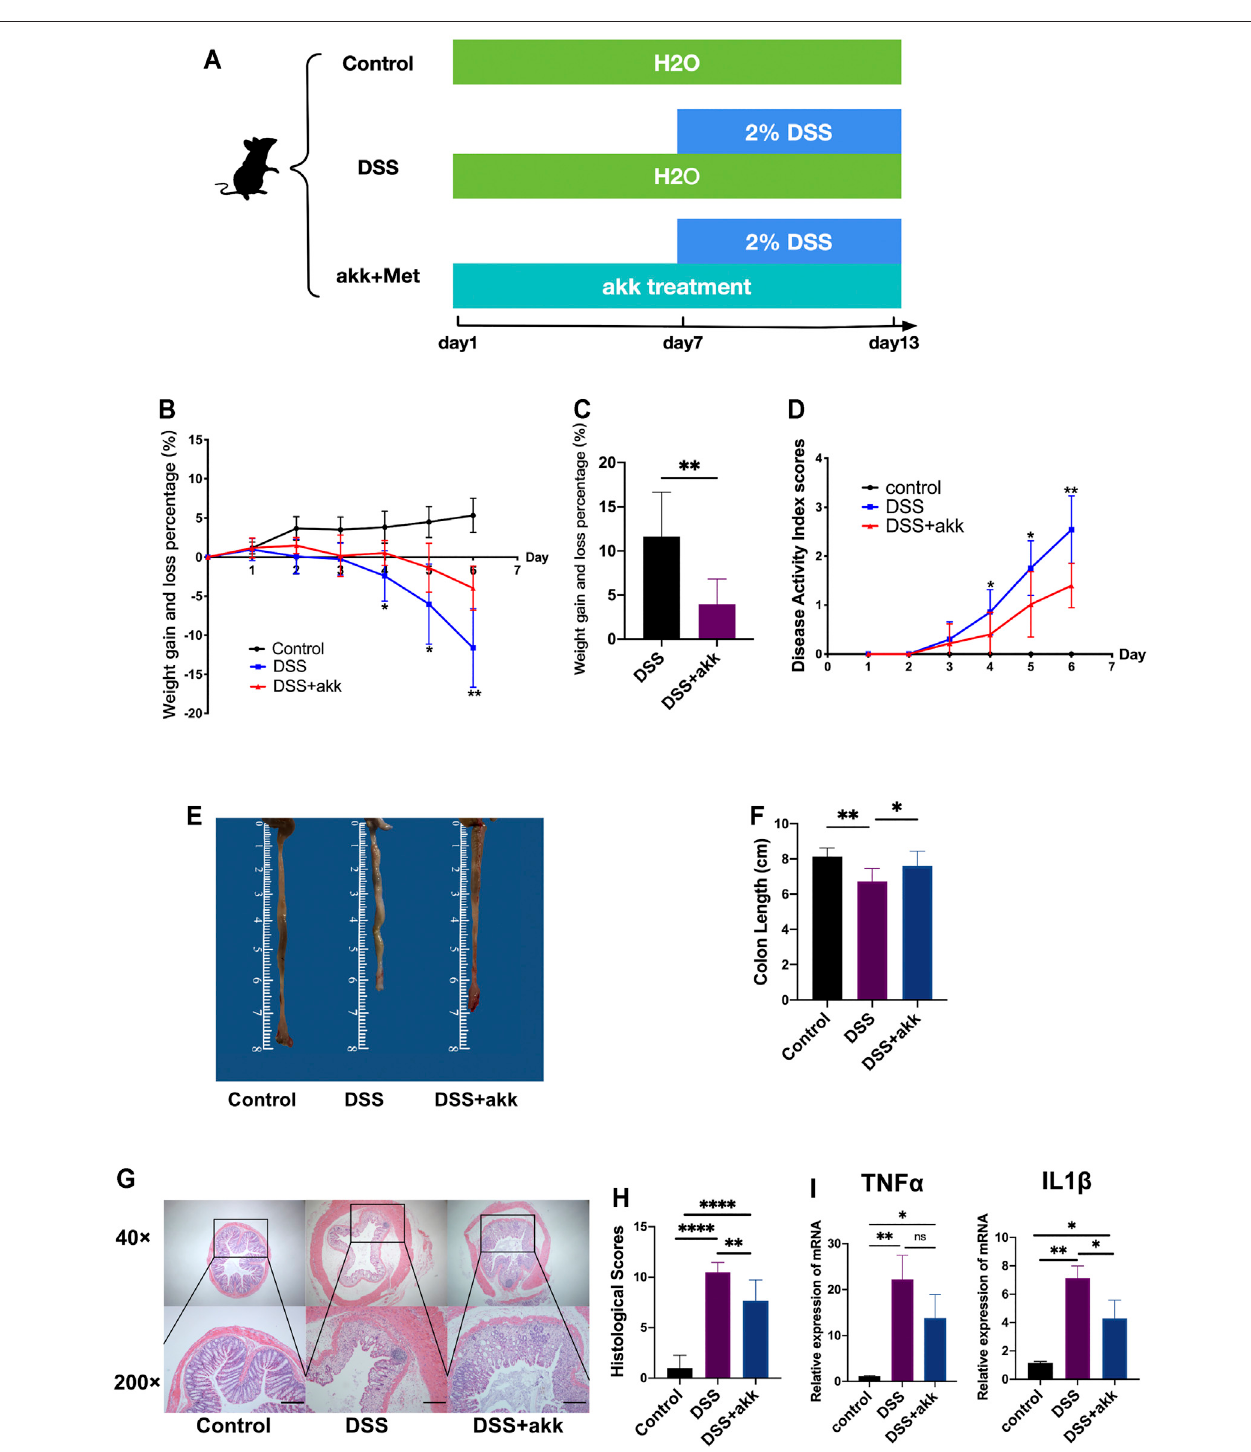
FIGURE7 | Akkermansiamuciniphila alleviates dextran sulfate sodium (DSS)-induced ulcerative colitis(UC) in mice. Flowchartof animal treatment (A) ,weight loss and gain during DSS treatment ( n (cid:1) 6 – 14) (B) and weight loss percentage at day 6 ( n (cid:1) 6 – 14) (C) , disease activity index (DAI) scores ( n (cid:1) 6 – 14) (D) , representative pictures of the mouse colon ( n (cid:1) 6 – 14) (E) , colon length ( n (cid:1) 6 – 14) (F) , hematoxylin and eosin (HE) staining of colon tissue (scale bars, 400 μ m) ( n (cid:1) 6 – 10) (G) , colon histological scores ( n (cid:1) 6 – 10) (H) , and RT-qPCR assay of tumor necrosis factor- α (TNF- α ) and interleukin 1 β (IL1 β ) in colon tissue ( n (cid:1) 2 – 6) (I) and statistical comparison was made using an ANOVA test followed by Tukey-Kramer post-hoc tests. * p < 0.05, ** p < 0.01, *** p < 0.001.